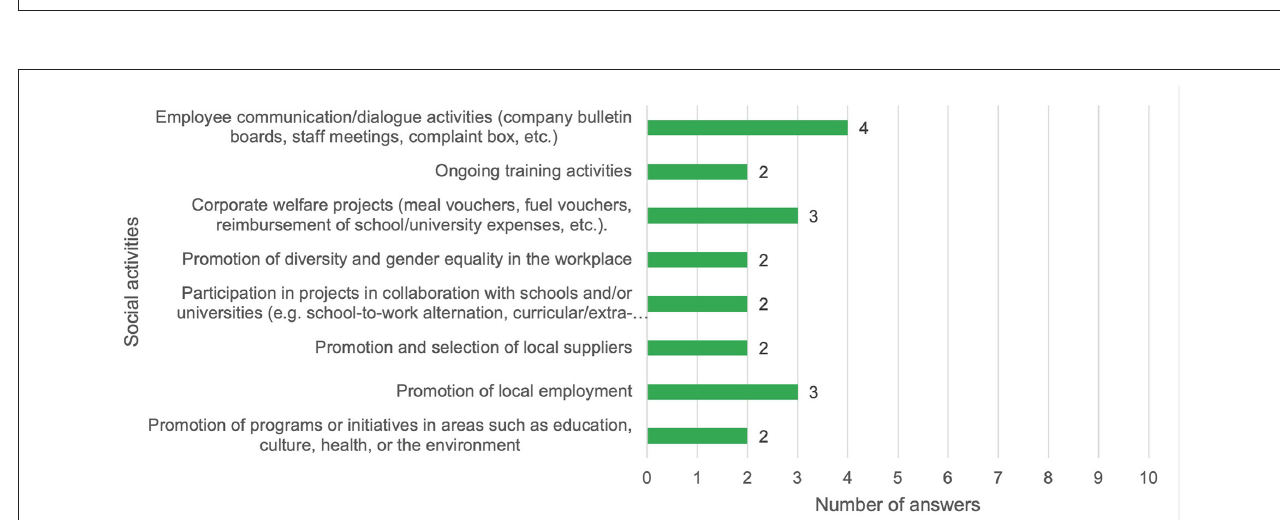
FIGURE 7 | Environmental activities.